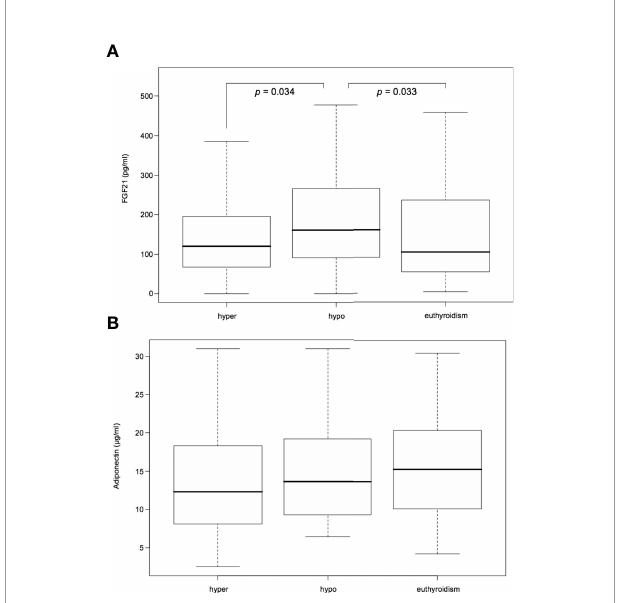
FIGURE 3 | Serum FGF21 (A) and adiponectin (B) levels after RAI treatment in hyper-, hypo-, and euthyroid phase. FGF21, fi broblast growth factor 21. Data presented as median (interquartile range). P<0.05 was considered signi fi cant.